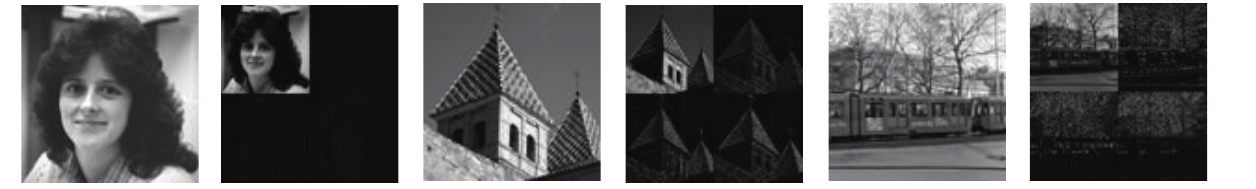
Figure 6: Relationship between detail subbands and image content.